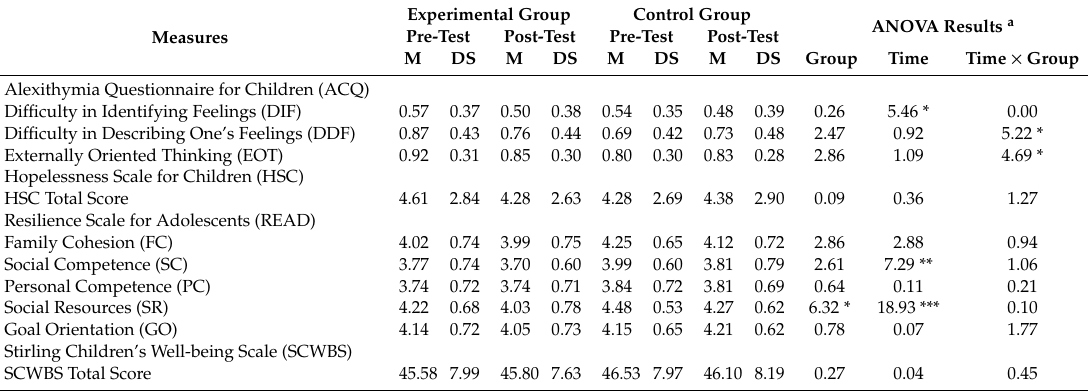
ANOVA Results a Pre-Test Post-Test Pre-Test Post-Test